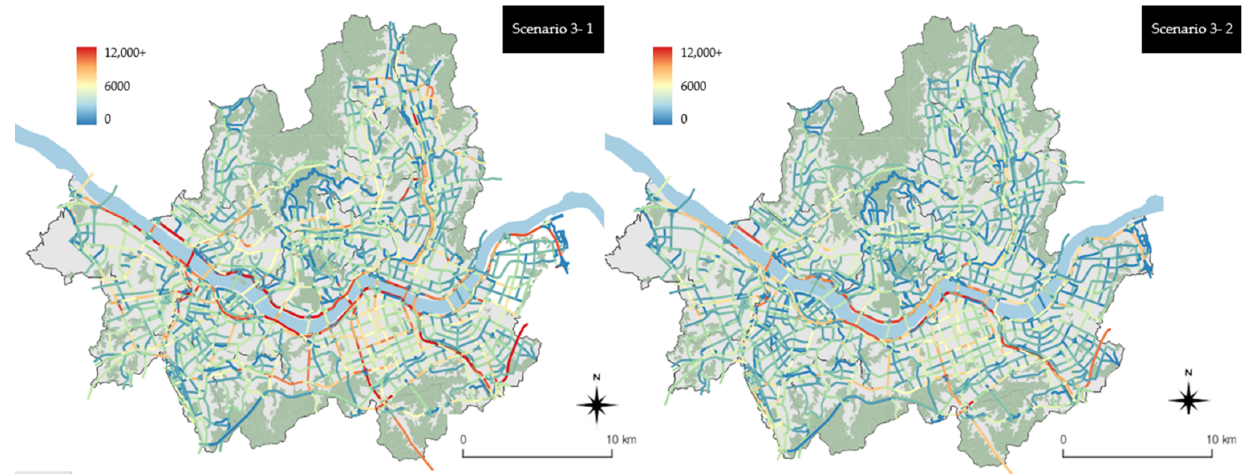
Figure 9. Scenario 3 vehicle emissions by the link units (using the existing range of the legend).